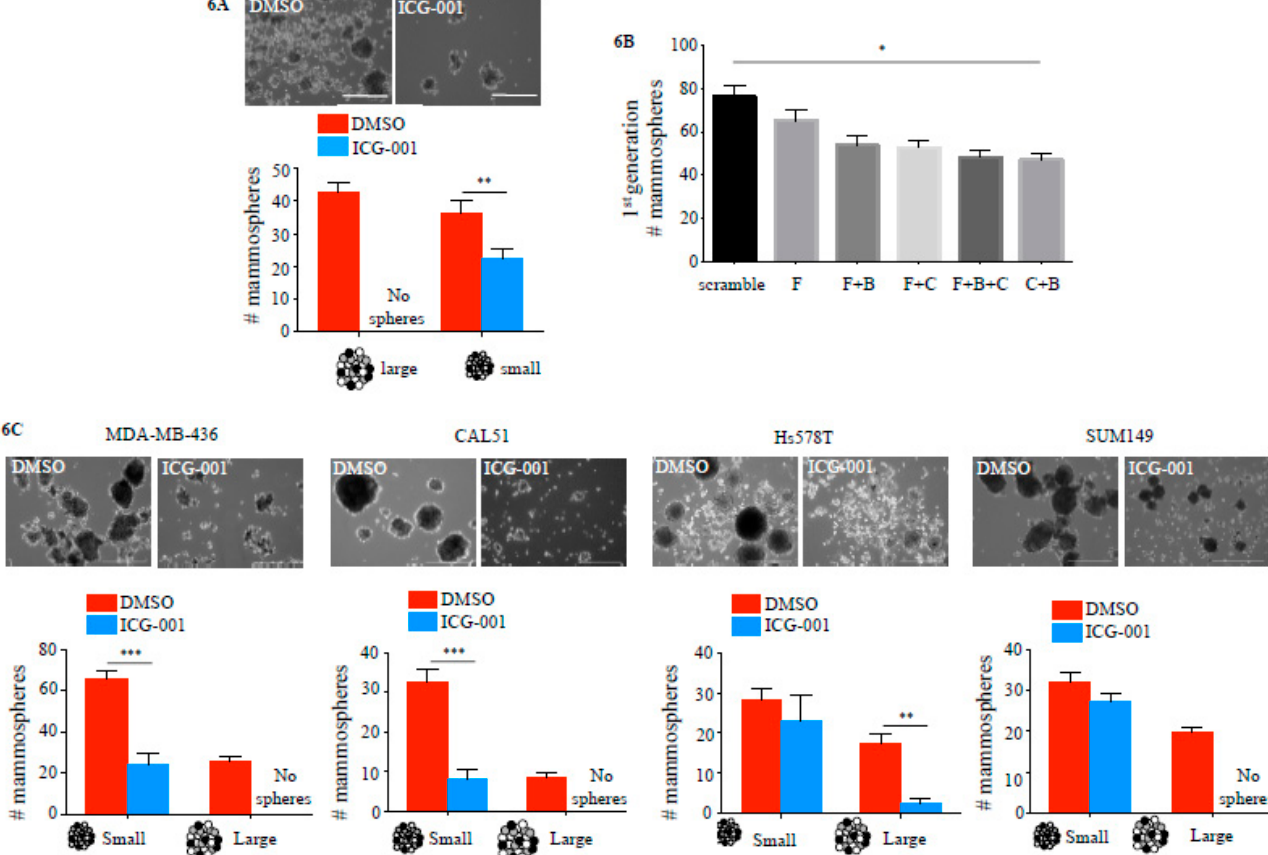
Figure 6. Targeting CBP reduces tumor initiation capacity in TNBC cell lines. ( A ) Tumorsphere formation of MDA-MB-231 cells treated for 9 days with 10 µ M ICG-001 or DMSO control (20,000 cells per well, n = 3 per condition) (scale bar = 100 µ m). ( B ) Seven-day culture of MDA-MB-231 after 48 h siRNA KD (F–FOXM1, B– β -catenin, C–CBP) (20,000 cells per well, n = 3 per condition). ( C ) Tumorsphere formation in additional TNBC cell lines (MDA-MB-436, CAL51, Hs578T and SUM149) after 7 days in culture, treated with 10 µ M ICG-001 or DMSO vehicle control ( n = 3 per cell line per condition). Large spheres < 50 µ m diameter, small spheres > 50 µ m (scale bar = 100 µ m) (* p < 0.05, ** p < 0.01, *** p < 0.001).